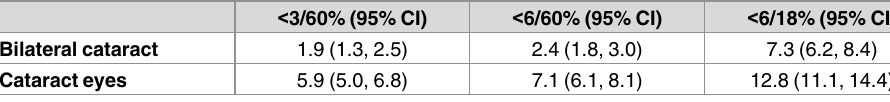
Table 2. Age-sexadjusted prevalenceof cataract: Wurno health zone 2016.